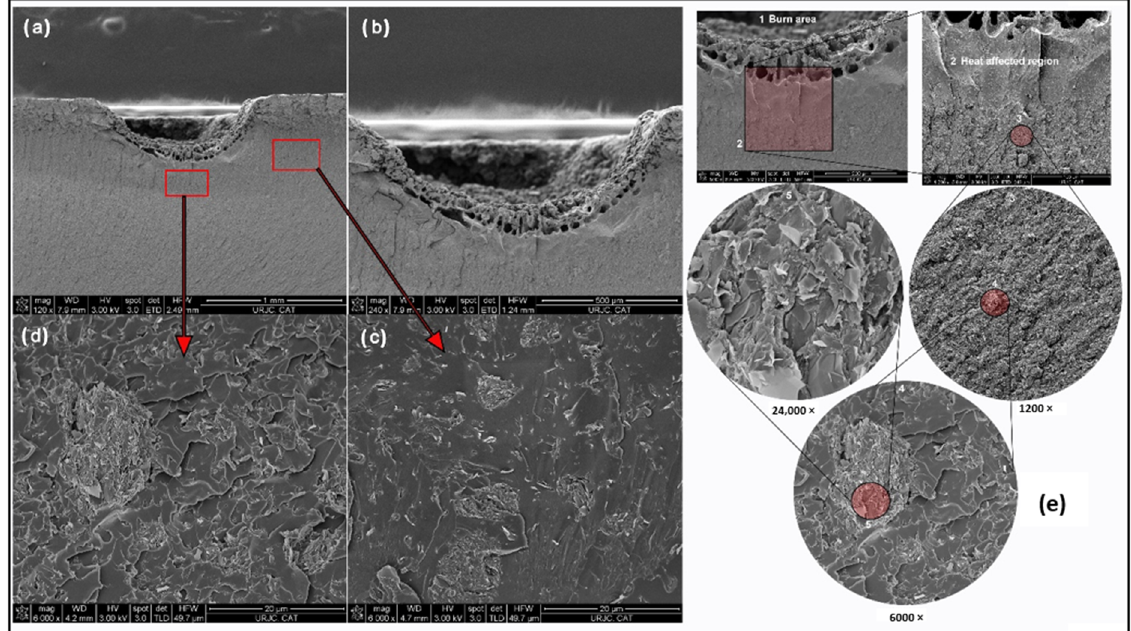
Figure 14. FEG-SEM Images of GNP/epoxy composites reinforced with C750. ( a ) Location of the crater generated by combustion in the preferential conductive path, ( b ) close-up of the crater, ( c ) GNP in the zone outside the combustion crater, ( d ) GNP in the zone where the preferential conductive path exists, and ( e ) detail of the crater zone at different magnifications (1200, 6000, and 24,000×). Red arrow is used to indicate the area that has been magnified.